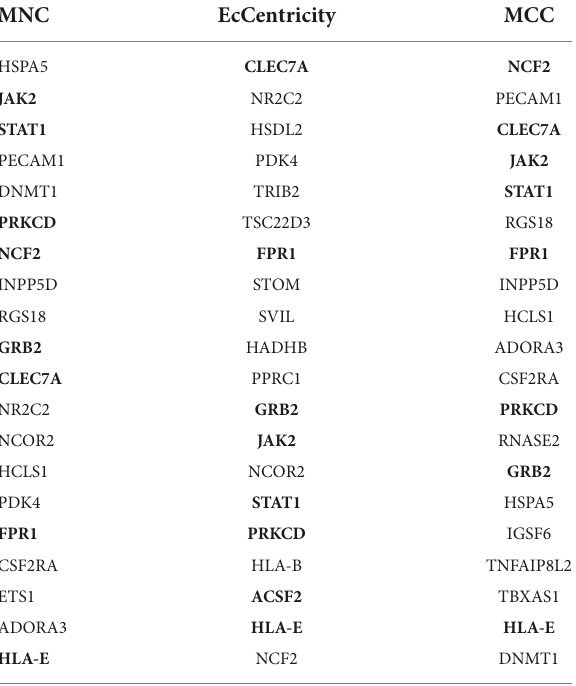
Bold gene symbols were the overlap hub genes in top 20 by three ranked methods, respectively in cytoHubba. MNC: maximum neighborhood component; MCC: maximal